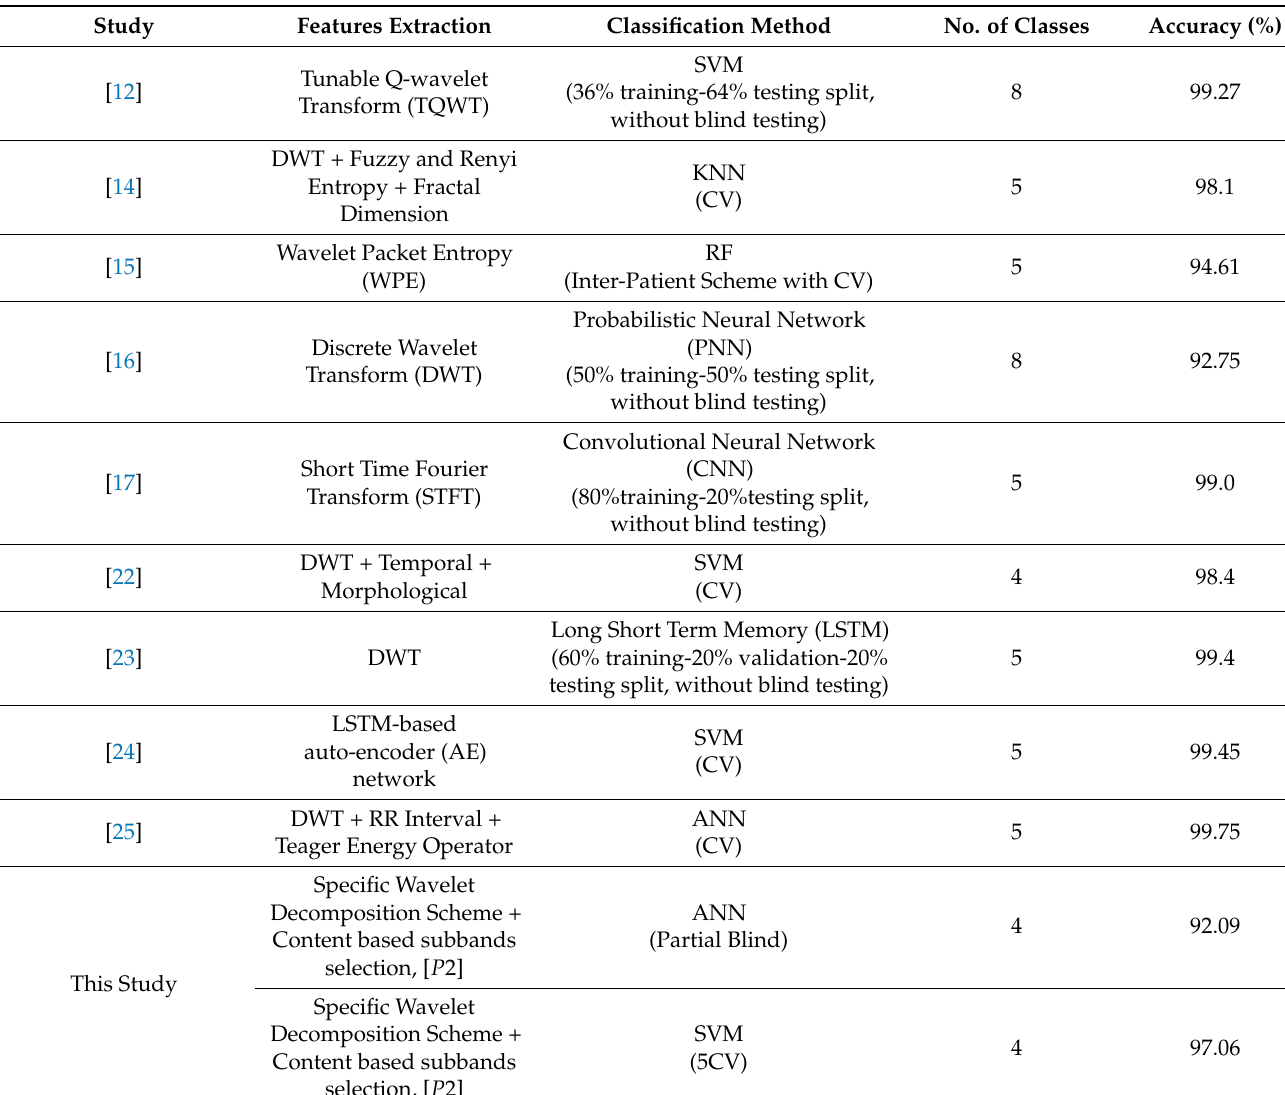
Table 9. Comparison with state-of-the-art